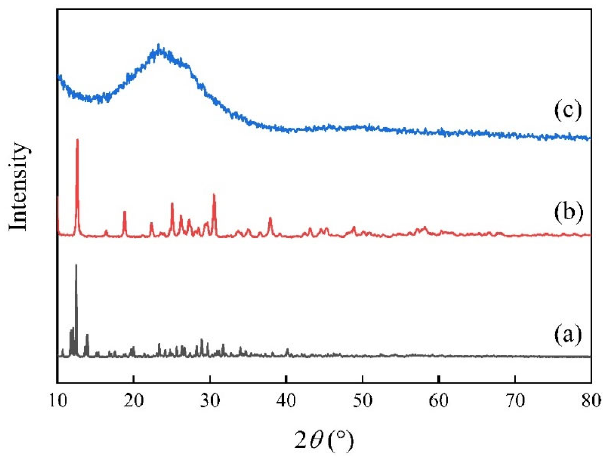
Figure 2. X ‐ ray diffractions of ammonium molybdate ( a ), MoO 3 ( b ), and Ce/MoO 3 /SiO 2 ( c ). Figure 2. X-ray diffractions of ammonium molybdate (a), MoO 3 (b), and Ce/MoO 3 /SiO 2 (c).